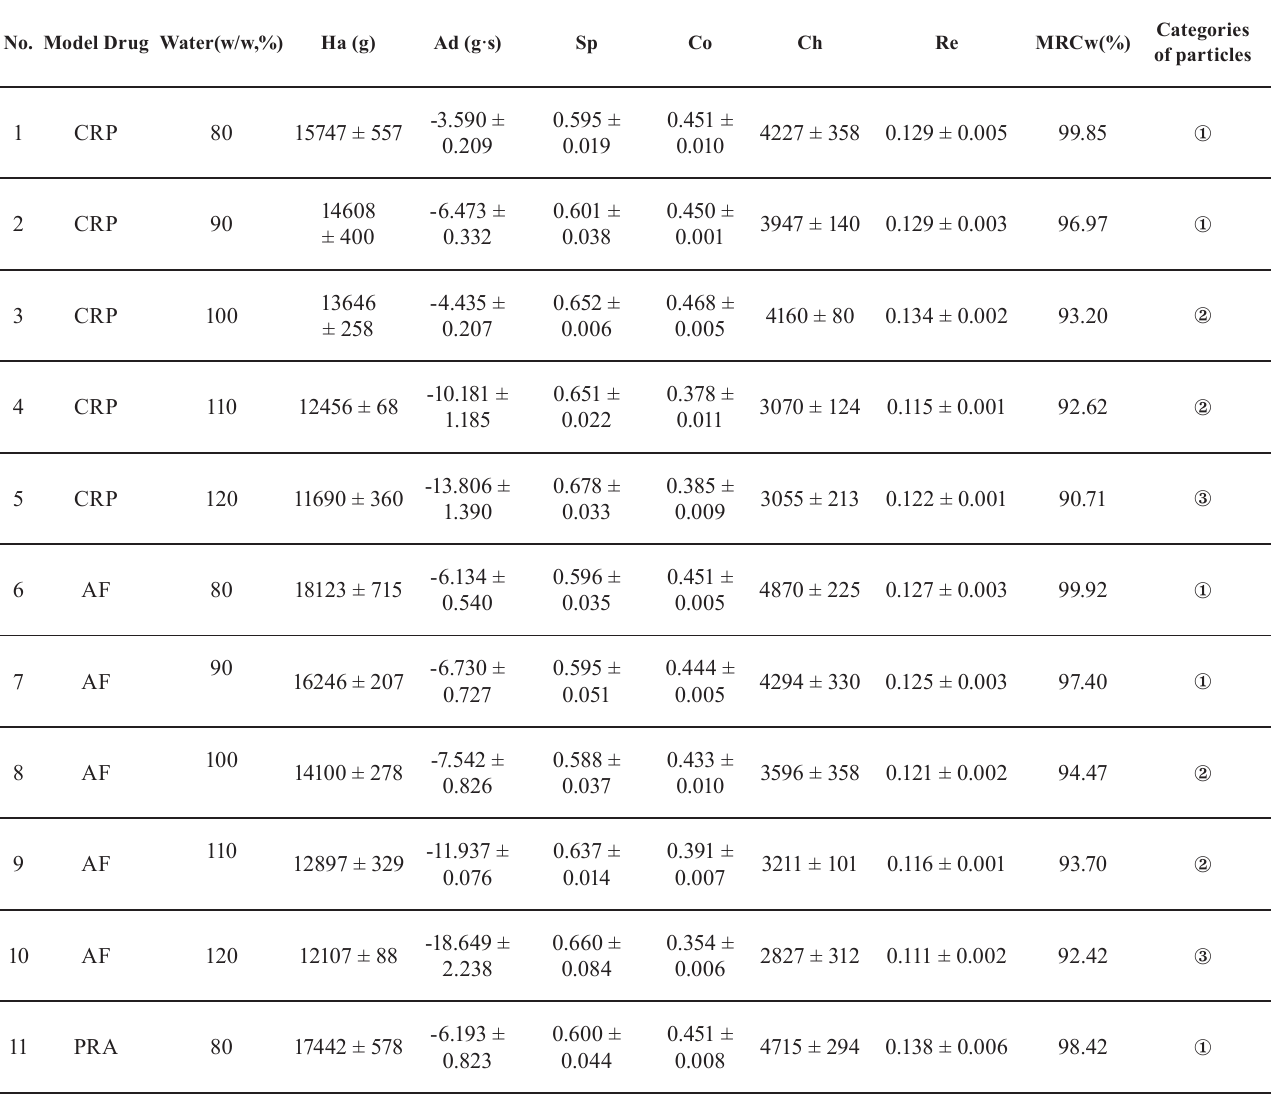
TABLE II – The physical properties of wet masses and categories of pellets from 100 formulations (n=3, x ± s)